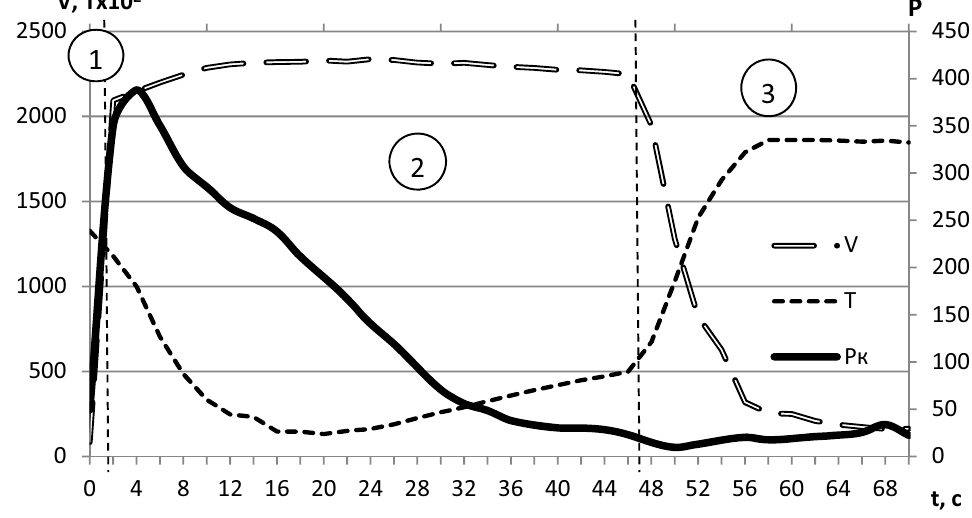
Figure 4. The average cycle parameters unloading chamber pump: V – air volume flow, m 3 /h; T – air temperature, 0 C; P K – the pressure in the chamber,